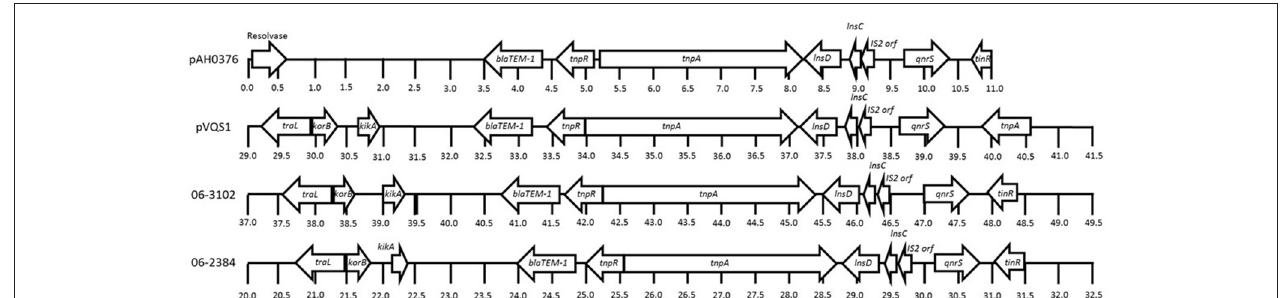
FIGURE 2 | Comparative alignment showing the blaTEM-1B , qnrS , and flanking mobile element protein genes from the plasmid sequences of pAH0376 ( Shigella flexneri 2b; GenBank: AB187515.1), pVQS1 ( Salmonella enterica ; GenBank: JQ609357.1), and Shigella flexneri 06-2384 and 06-3102 have nearly identical homology and synteny. Arrowheads represent annotated protein coding sequences and direction of their transcription. Numbers below each sequence represent distance expressed in